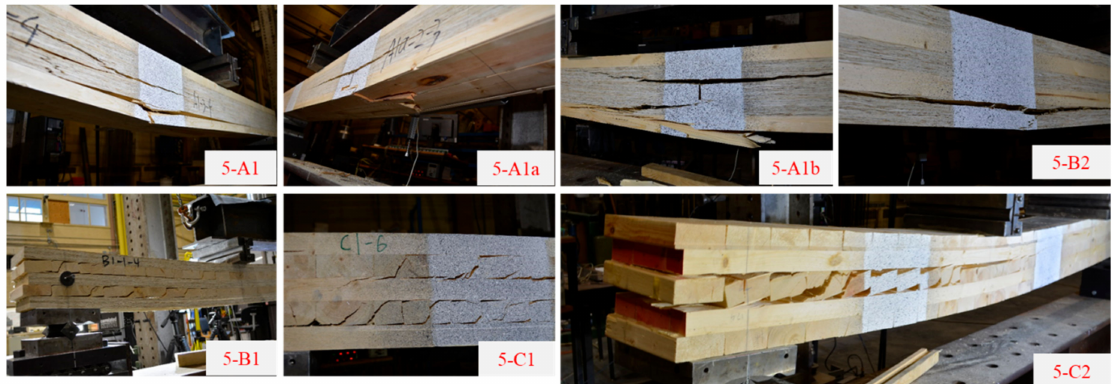
Figure 12. Typical failure modes under third-point bending